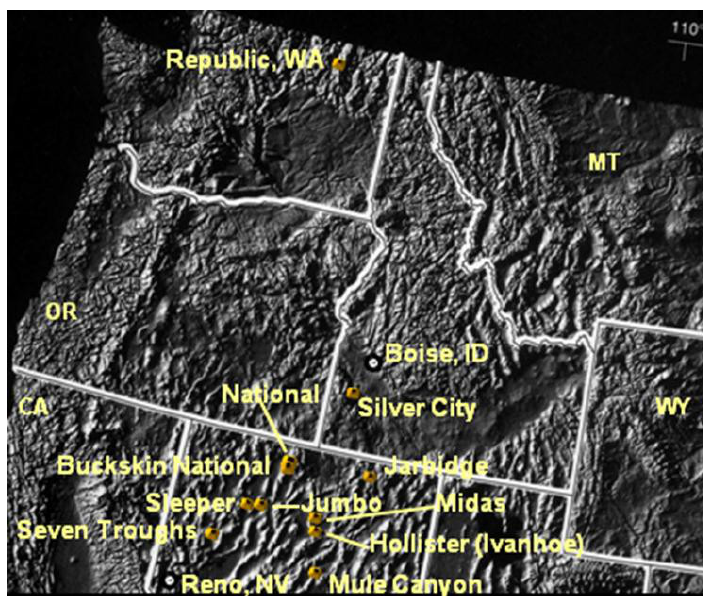
Figure 1. Location map of Tertiary low sulfidation (LS) epithermal deposits (and/or districts) exhibiting evidence of nanoparticles in bonanza